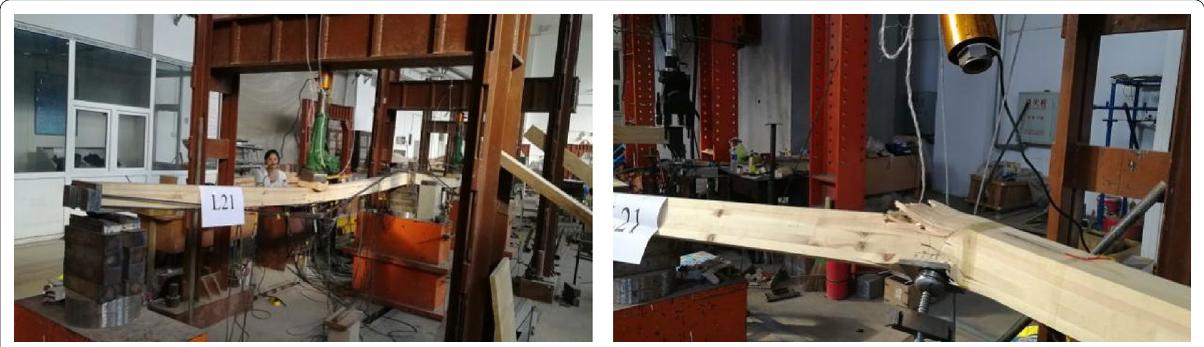
Fig. 8 Instability failure